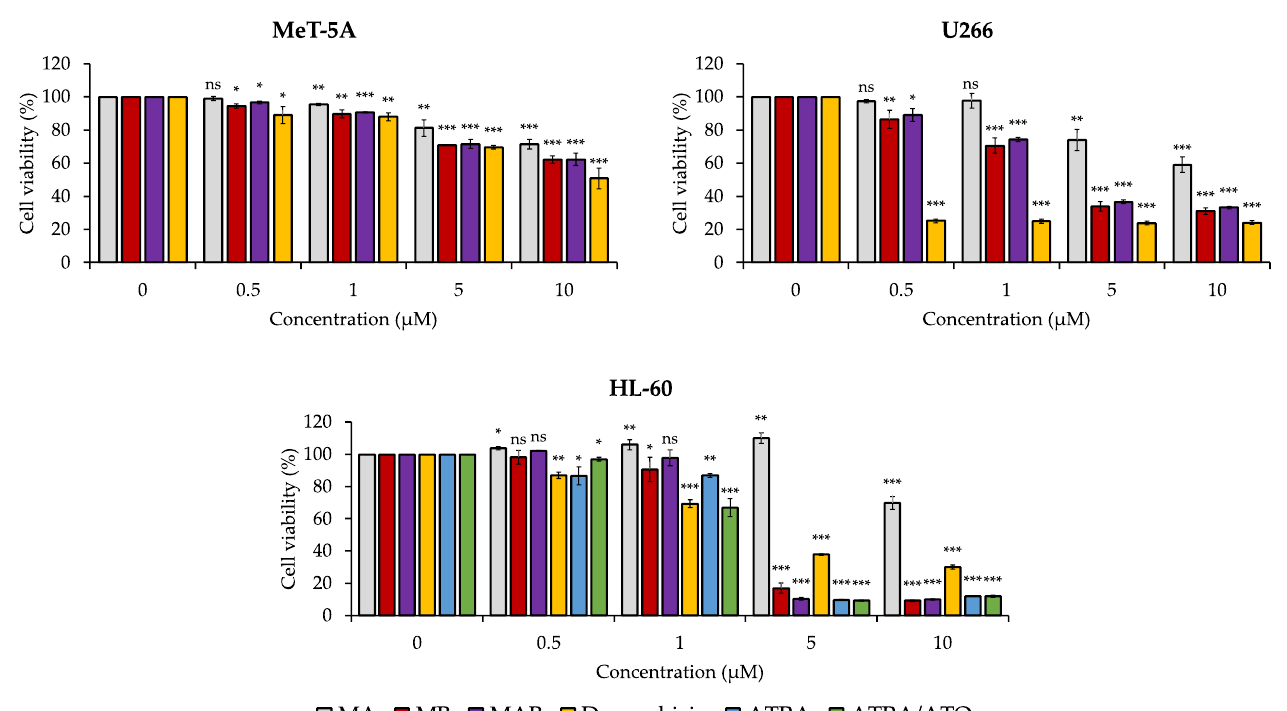
Figure 1. Effects of momilactones A (MA) and B (MB) and their mixture (MAB) (1:1, w / w ) on cell viability of non-cancerous (MeT-5A), acute promyelocytic leukemia (HL-60), and multiple myeloma (U266) cell lines after 48 h. Data are expressed as mean ± standard deviation (SD). Statistical significance was determined by the t -test. * p < 0.05 versus control (0 µM), ** p < 0.01 versus control (0 µM), *** p < 0.001 versus control (0 µM). ATRA, all-trans retinoic acid; ATRA/ATO, the mixture of all-trans retinoic acid and arsenic trioxide (1:1, w/w ); ns, not significant versus control (0 µM).